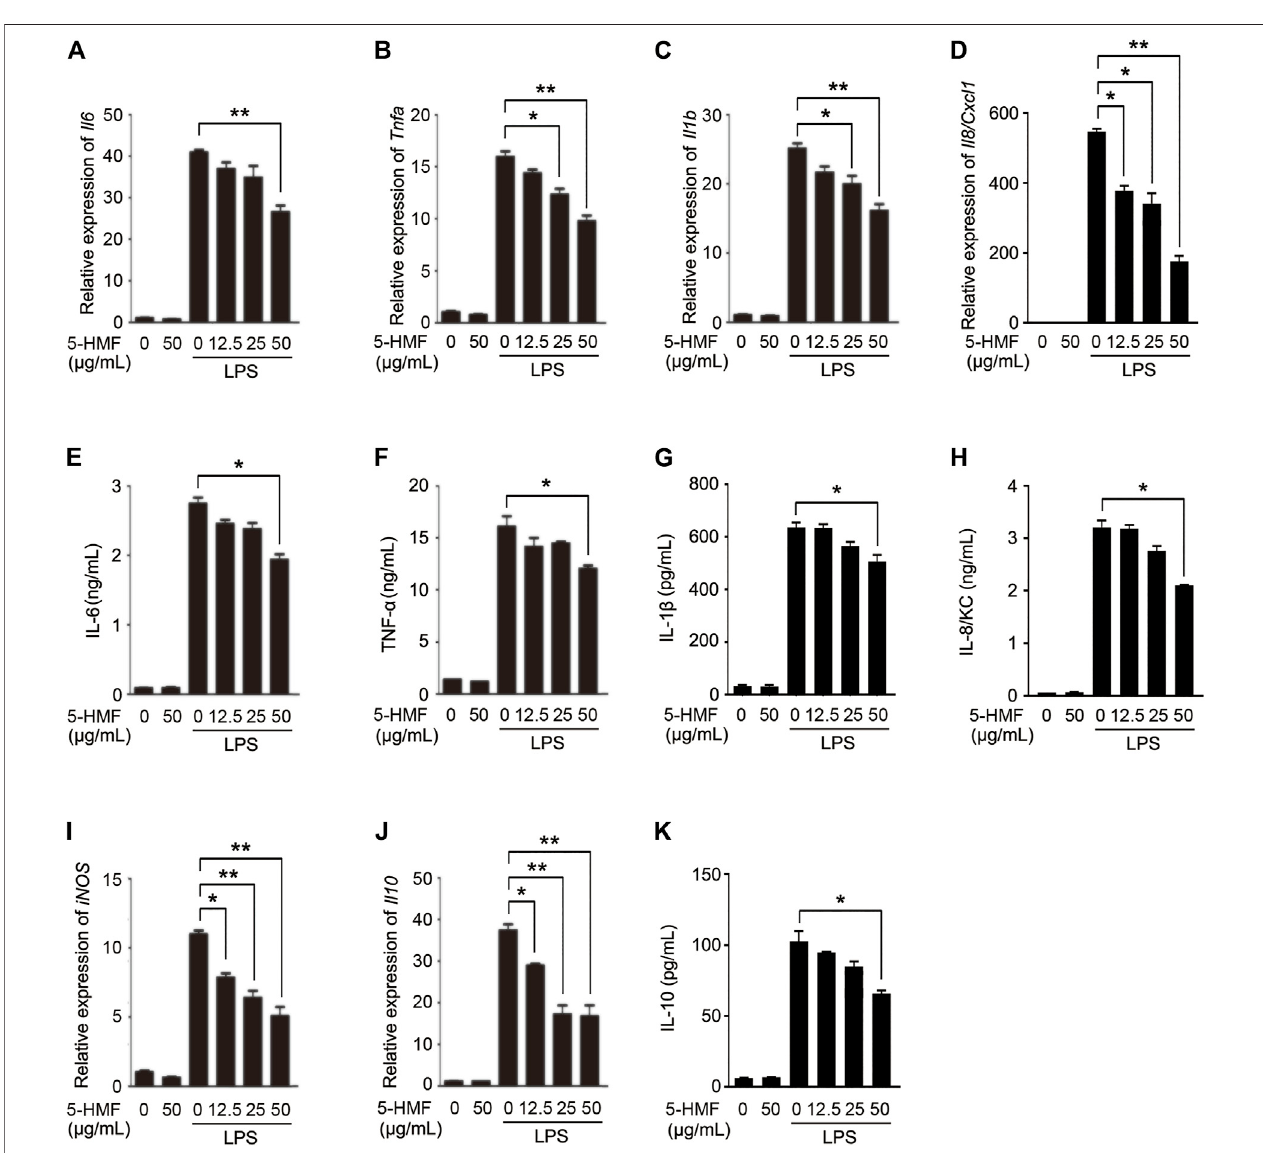
FIGURE 2 | 5-HMF inhibits the production of LPS-triggered proin fl ammatory cytokines in BMDMs. BMDMs were pretreated with PBS or 5-HMF and stimulated with LPS (100 ng/ml). (A – D) Il6 (A) , Tnfa (B) , Il1b (C) and Il8/Cxc1 (D) mRNA levels. (E – H) IL-6 (E) , TNF- α (F) , IL-1 β (G) and IL-8/KC H) levels in the culture supernatant. (I,J) iNOS (I) and Il10 (J) mRNA levels. (K) IL-10 levels in the culture supernatant. Data are the mean ± SD of three independent experiments: * and ** indicate p < 0.05 and p < 0.01 respectively by Student ’ s t-test.